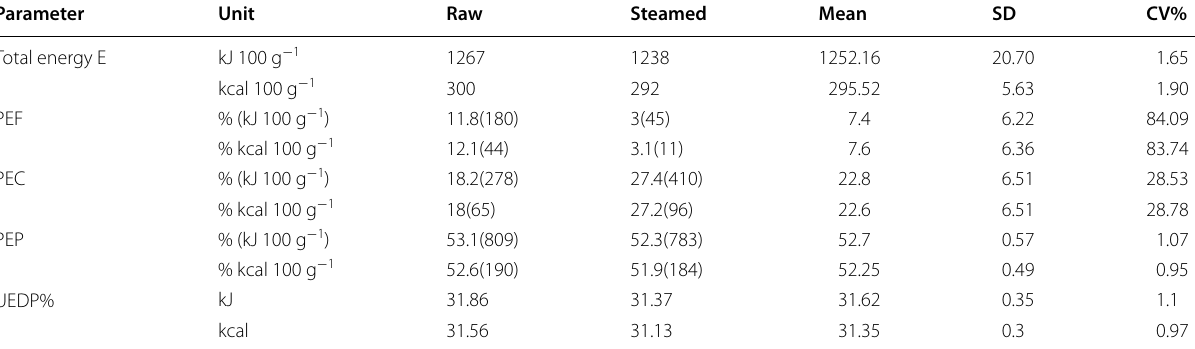
Total energy (TE), proportion of total energy due to fat (PEF), proportion of total energy due to carbohydrate (PEC), proportion of total energy due to protein(PEP), utilization of energy value due to protein (UEDP%), standard deviation (SD), coefficient of variation per cent (CV%)